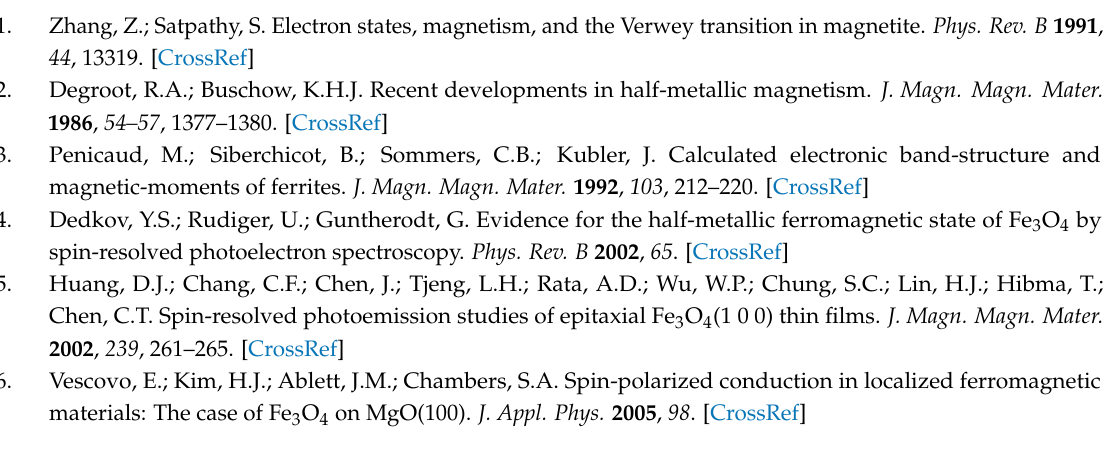
s1, Figure S1: X-ray diffraction scans of Fe 3 O 4 films grown at different temperatures on Al 2 O 3 (0001). Table S1: The average grain size calculated for Fe 3 O 4 films grown on Al 2 O 3 substrate. Figure S2: Phi scan of the (511) reflection for a Fe 3 O 4 film on MgO(100). Table S2: The FWHM, rocking curve, a lattice parameter, and average grain size values of the Fe 3 O 4 films on MgO substrate. Figure S3: SEM images of Fe 3 O 4 films on Al 2 O 3 (0001) substrates grown in Ar atmosphere. The images in the left and right column correspond to films grown without and with a magnetic field, respectively. Figure S4: SEM images of Fe 3 O 4 films on MgO(001) substrates grown in Ar atmosphere. The images in the left and right column correspond to films grown without and with a magnetic field, respectively. Figure S5: In-plane (left) and out-of-plane (right) hysteresis curves of Fe 3 O 4 films grown on MgO substrates at 550 ◦ C with and without an external magnetic field of 1 T. The blue data points indicate the effect of cooling in an external magnetic field of 1